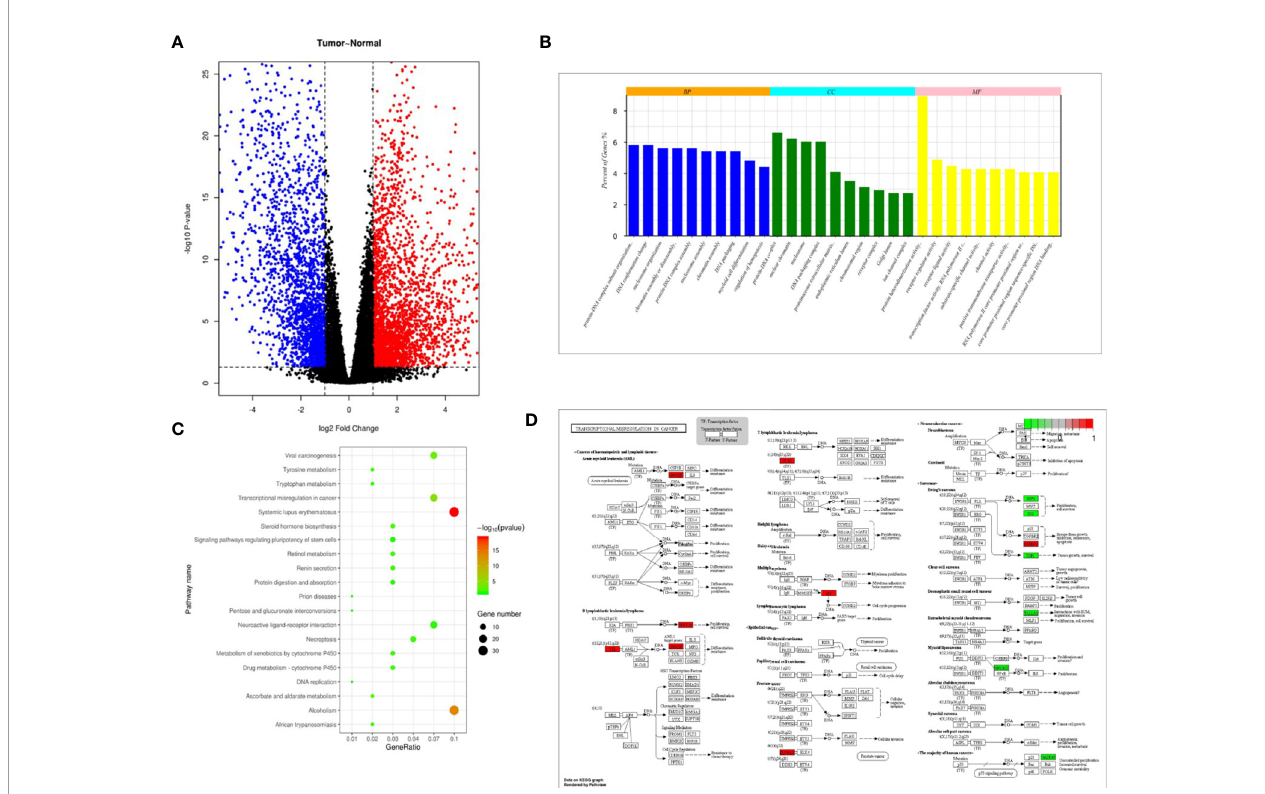
FIGURE 1 | Differentially expressed genes in TCGA dataset, and pathway enrichment of TSPAN7. (A) Volcano plot visualizing the all differentially expressed genes in TCGA dataset, (B) GO enrichment, (C) KEGG pathway, and (D) Transcriptional misregulation in